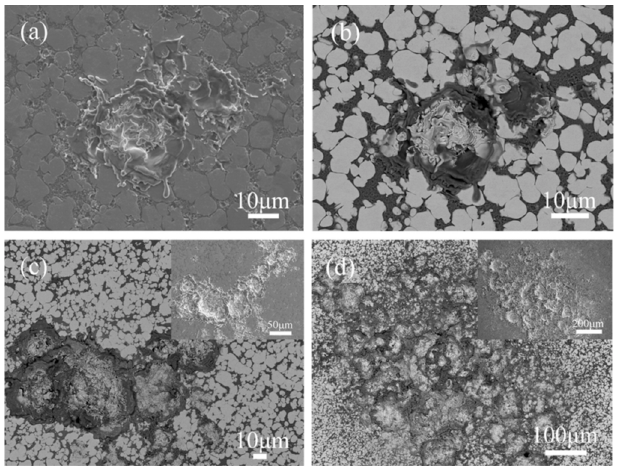
Figure 10. Surface morphology and microstructure of W 70 Cu 30 : ( a ) alloy morphology after the first breakdown, ( b ) alloy microstructure after the first breakdown, ( c ) alloy microstructure after 5 breakdowns, ( d ) alloy microstructure after 50 breakdowns [36].